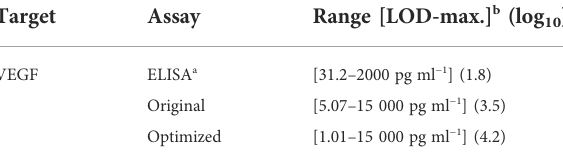
TABLE 1 The limit of detection and dynamic range of ELISA, the original particle assay, and the optimized conjugation process